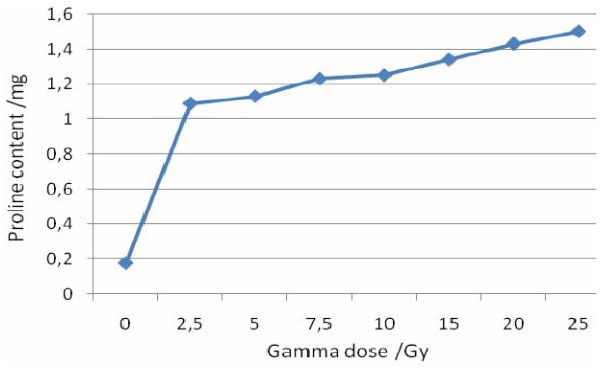
Fig. 8. Effect of gamma radiation doses on total soluble protein in haploid